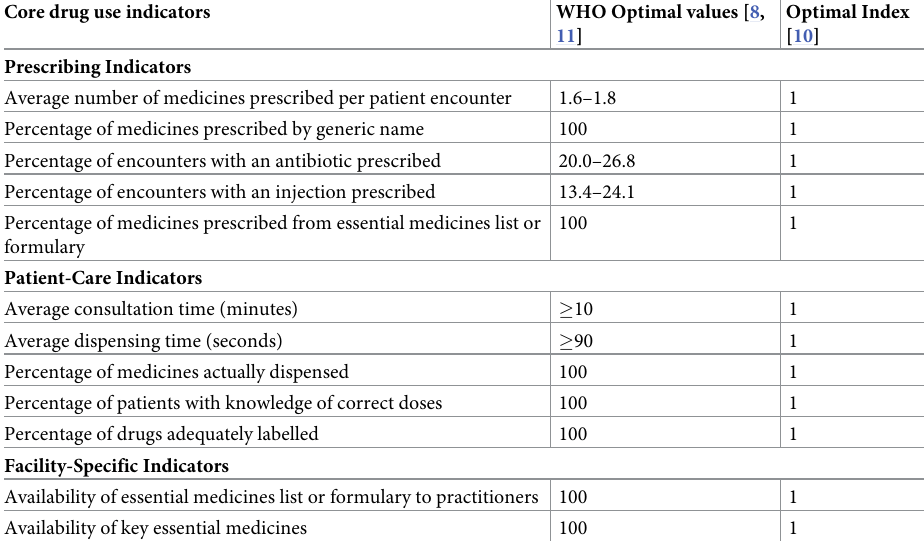
Table 1. Core drug use indicators and their optimal